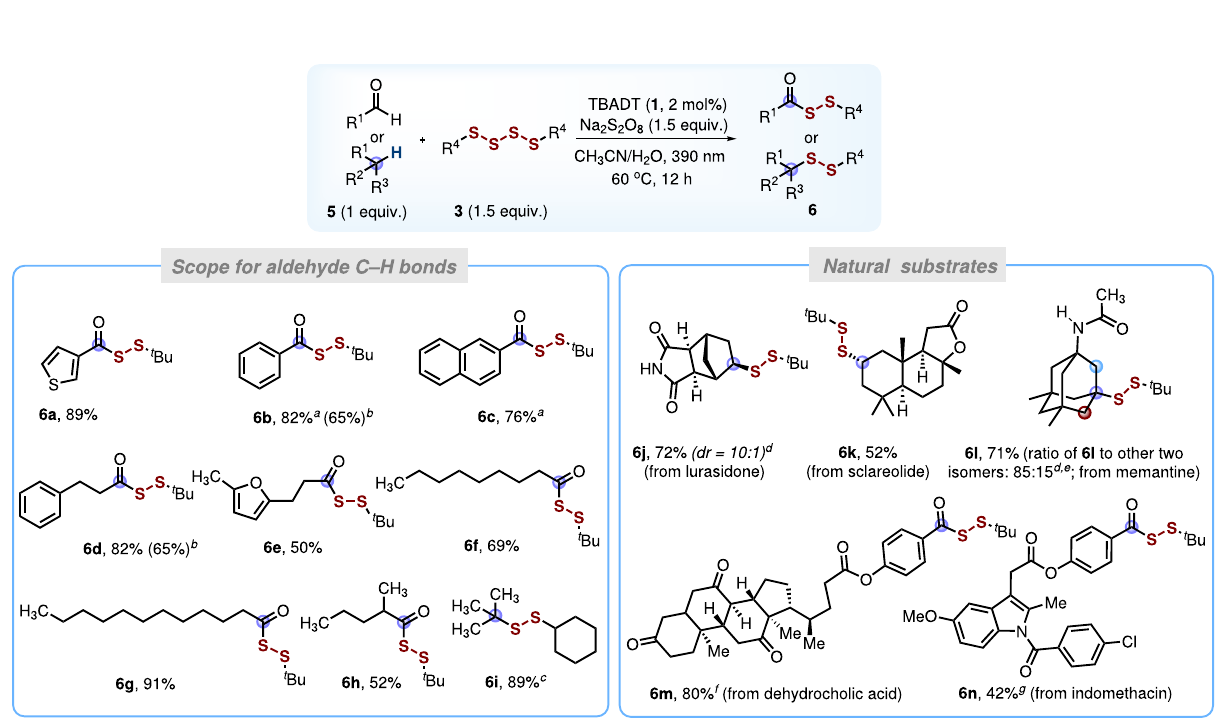
Fig. 5 Products obtained by disulfuration of aldehydes and functionalization of natural compounds. Isolated yields are provided. Reaction conditions: substrate 5 (0.3 mmol, 1.0 equiv.), tetrasul fi de 3a (0.45 mmol, 1.5 equiv.), TBADT 2 mol%, Na 2 S 2 O 8 (0.45 mmol, 1.5 equiv.), solvent 3 mL (CH 3 CN/H 2 O, v / v , 2/1), 390 nm, Ar, 60 °C, and 12 h. a Reaction time: 4 h. If the reaction time is extended to 12 h, some of the products will decompose into aroylmonosul fi des (see SI for details). b Reaction conducted at room temperature. c With tetrasul fi de 3b (1.5 equiv.). d Determined by 1 H NMR spectroscopy. e Reaction run in the absence of Na 2 S 2 O 8 in 3 mL [CH 3 CN/(HCl aq. 1.0 M), v / v , 2/1]. f Reaction conditions: substrate 5m (0.2 mmol, 1.0 equiv.), 5 h. g Reaction conditions: substrate 5n (0.1 mmol, 1.0 equiv.), room temperature, 12